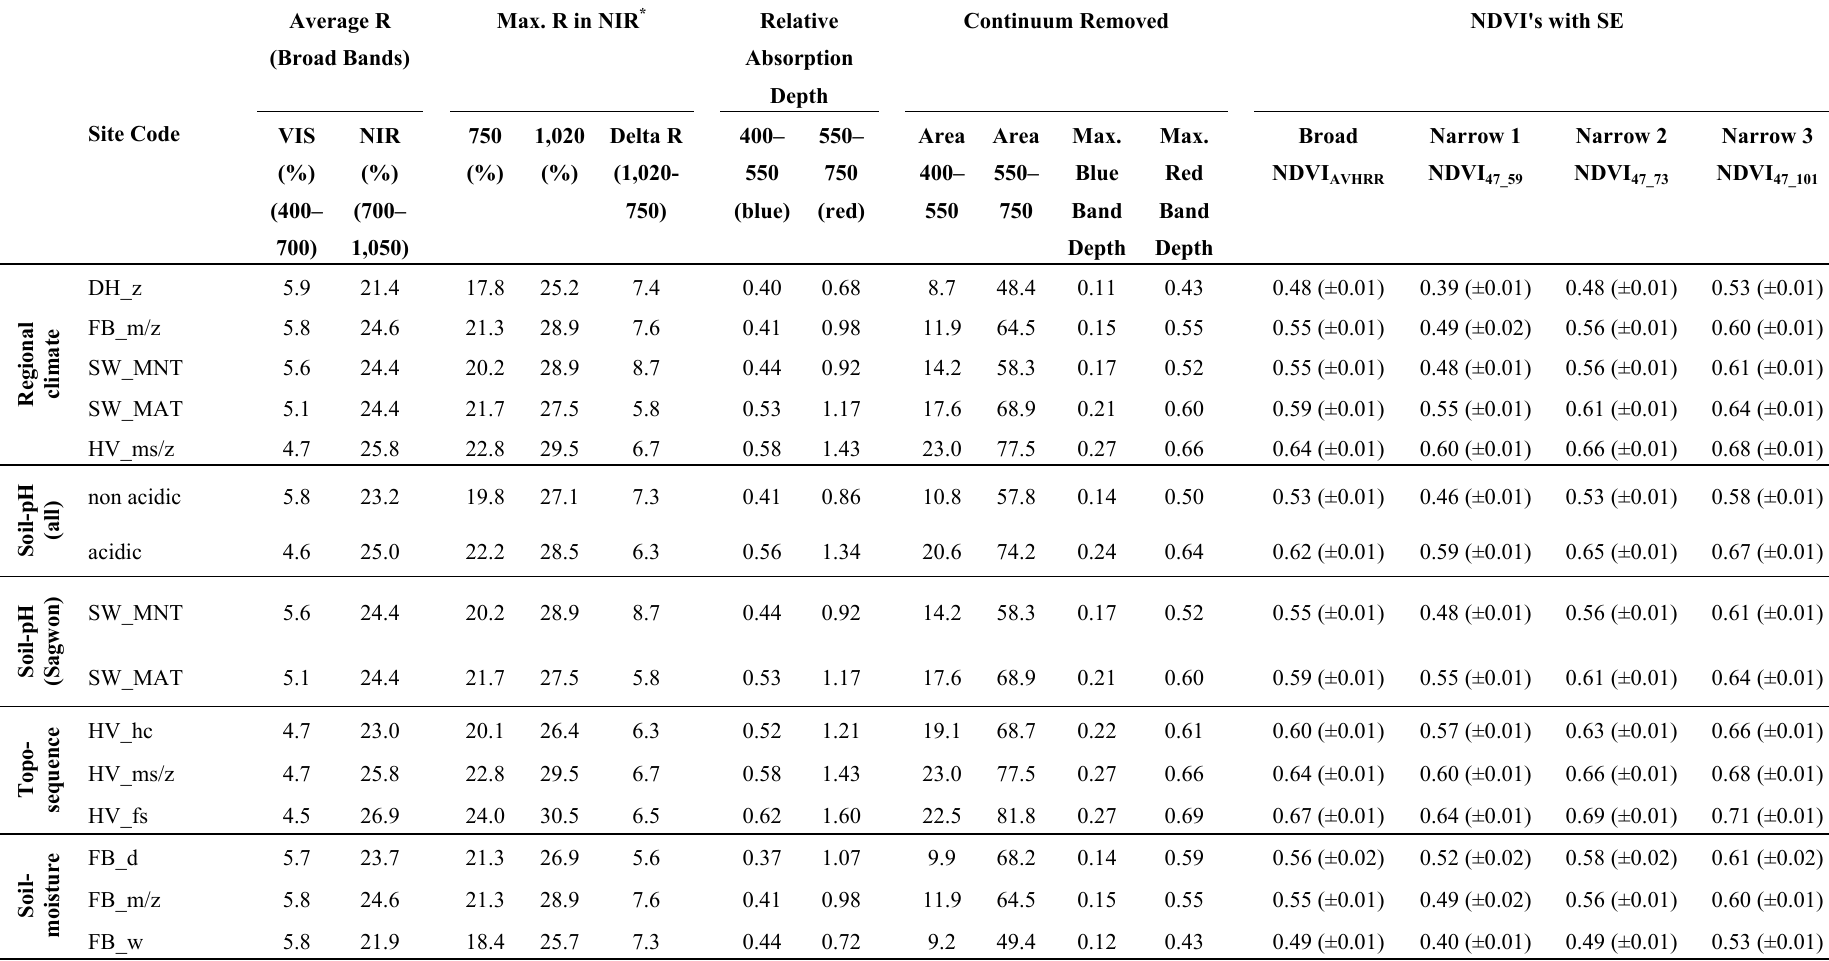
Table 3. Metrics of the spectral data